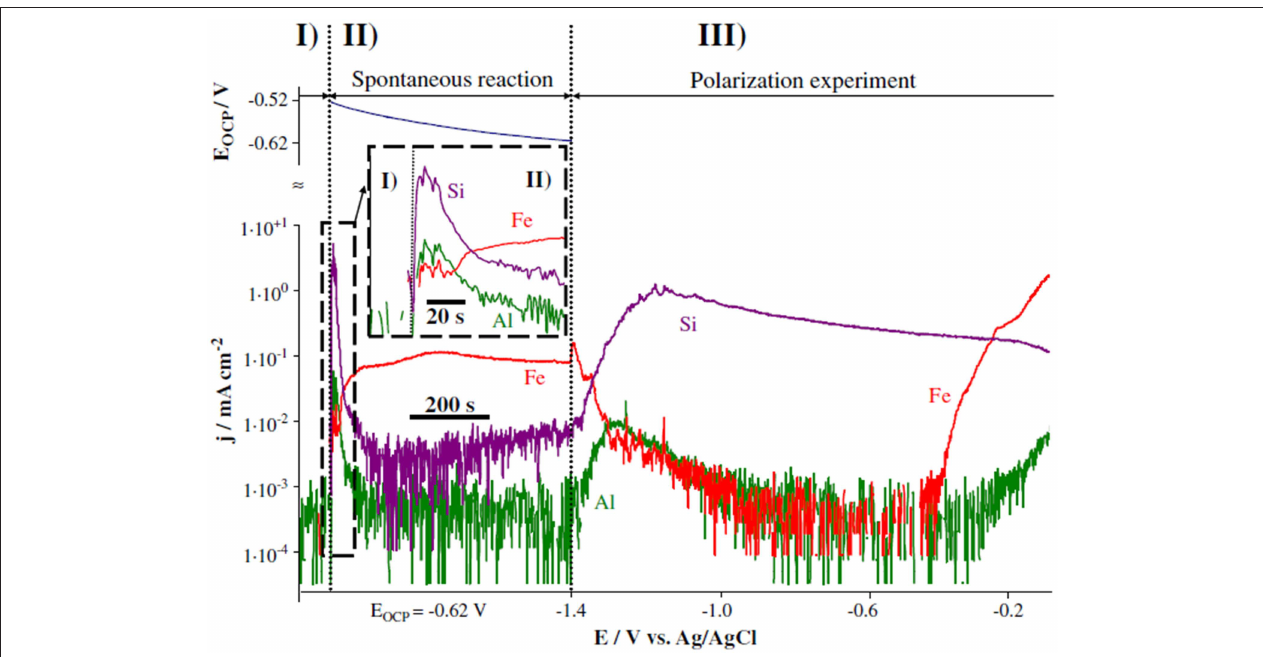
FIGURE 11 | Dissolution rates of Fe, Si, and Al measured through AESEC during both open circuit and applied polarization experiments to evaluate the mechanism of degradation in a silicone-based galvanic coating in 30 g/L NaCl environment ( Feliu et al., 1993a). Reproduced with